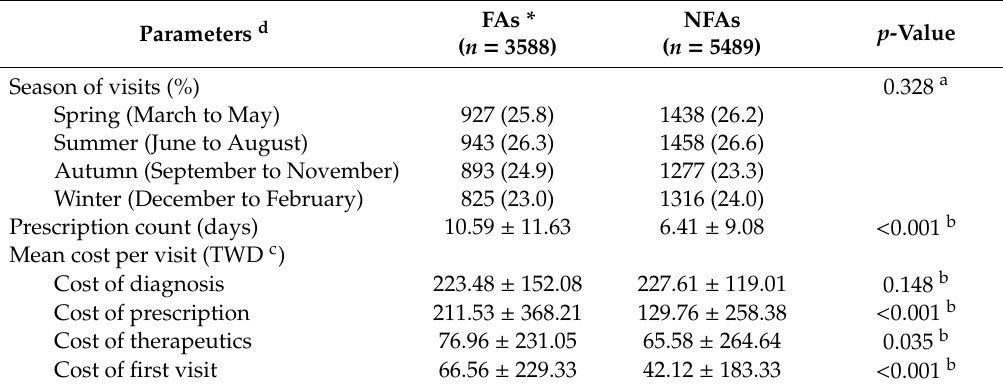
Table 2. Season and cost of subjects’ visits ( n =